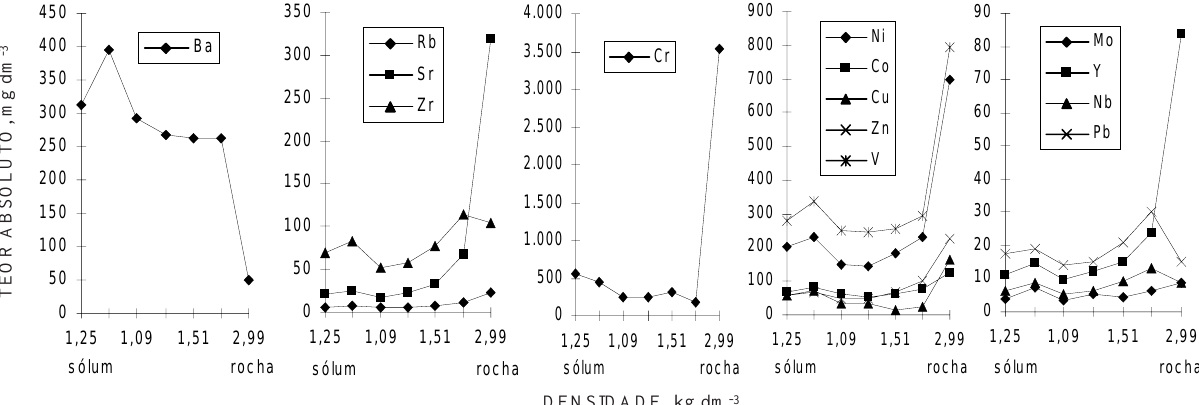
Figura 3. Diagramas de distribuição dos elementos maiores em teores absolutos em função da densidade para o perfil 3 –